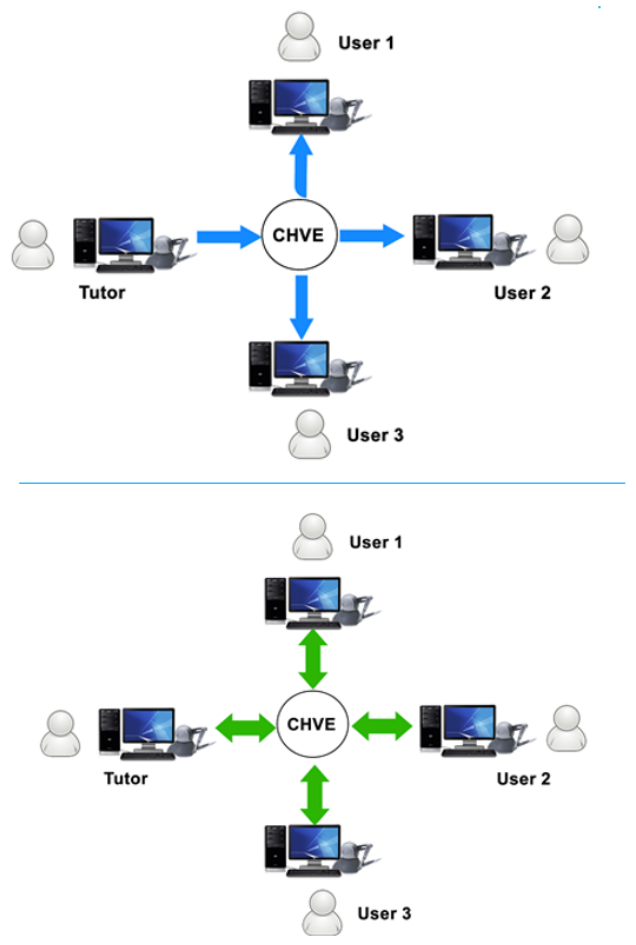
Fig. 2: Architectures of Collaborative Haptic Virtual Environments (CHVEs). Unilateral (top) and bilateral (bottom)